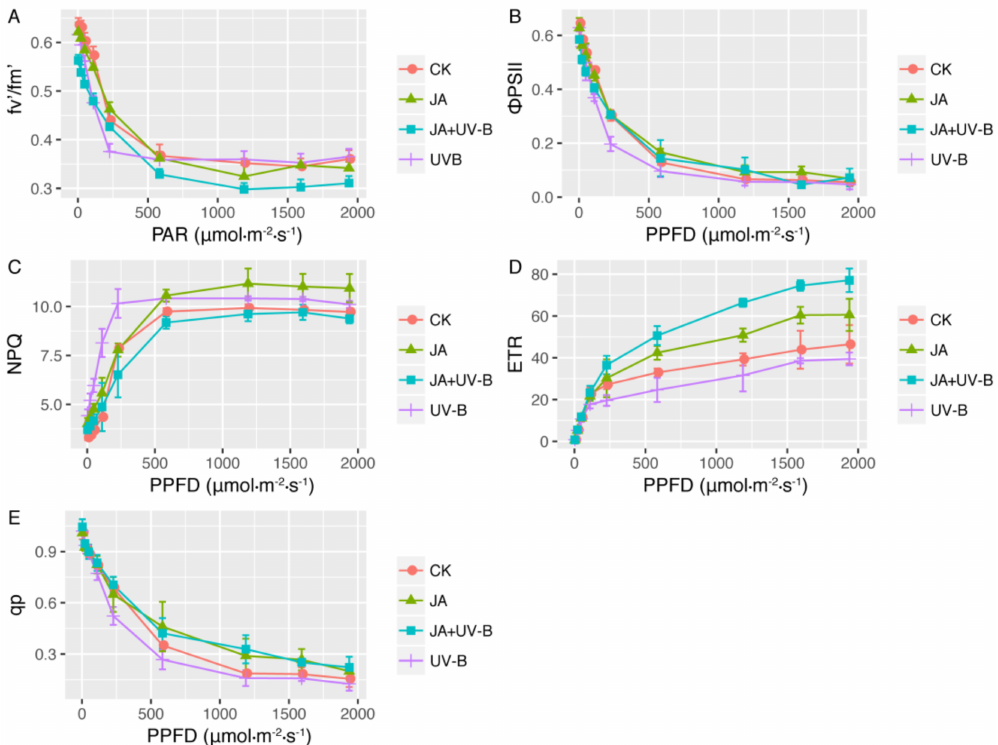
Figure 2. Influence of UV-B radiation and JA pretreatment on electron transport rate (ETR) ( D ), photochemical quenching (qp) ( E ), non-photochemical quenching (NPQ) ( C ), actual PSII efficiency ( φ PSII) ( B ) and efficiency of energy harvested by open PSII reaction centers (Fv’/Fm’) ( A ) from light-response curves of fluorescence in different treatments. CK (the control), JA (seedlings were sprayed with 1 mM JA), UV-B (seedlings were treated with 15-d elevated UV-B radiation), JA+UV-B (seedlings were sprayed with 1 mM JA before additional 15-d UV-B radiation). Measurements were made from 0 to 1950 µ mol · m − 2 · s − 1 . Each point represents the mean value of 3 leaves from 3 seedlings. Data are means ±